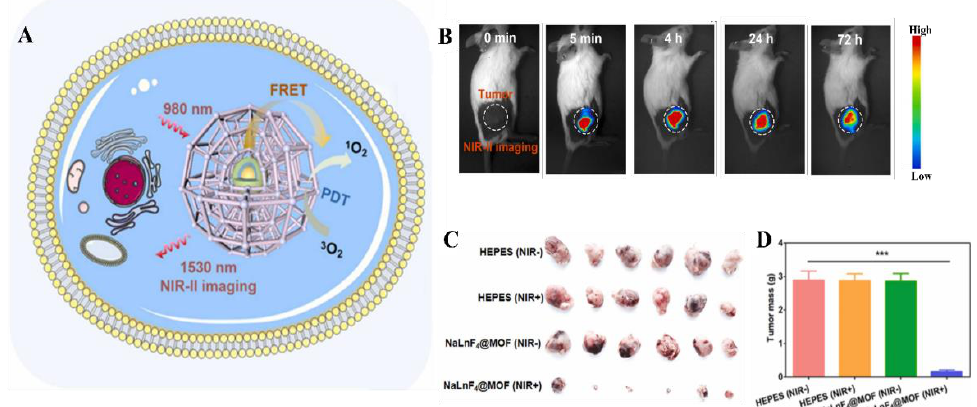
Figure 6. ( A ) Schematic illustration of NaLnF 4 @MOF in a cell for NIR-triggered photodynamic ther- apy and NIR-II bioimaging for diagnosis. ( B ) NIR-II images of BALB/c tumor-bearing mice treated with NaLnF4@MOF nanoparticles after intratumoral injection (0 min, 5 min, 4 h, 24 h and 72 h). ( C ) The images and ( D ) mass of excised tumors after two weeks post-injection (HEPES is the buffer solution as a control, *** p < 0.001) (Reprinted with permission from